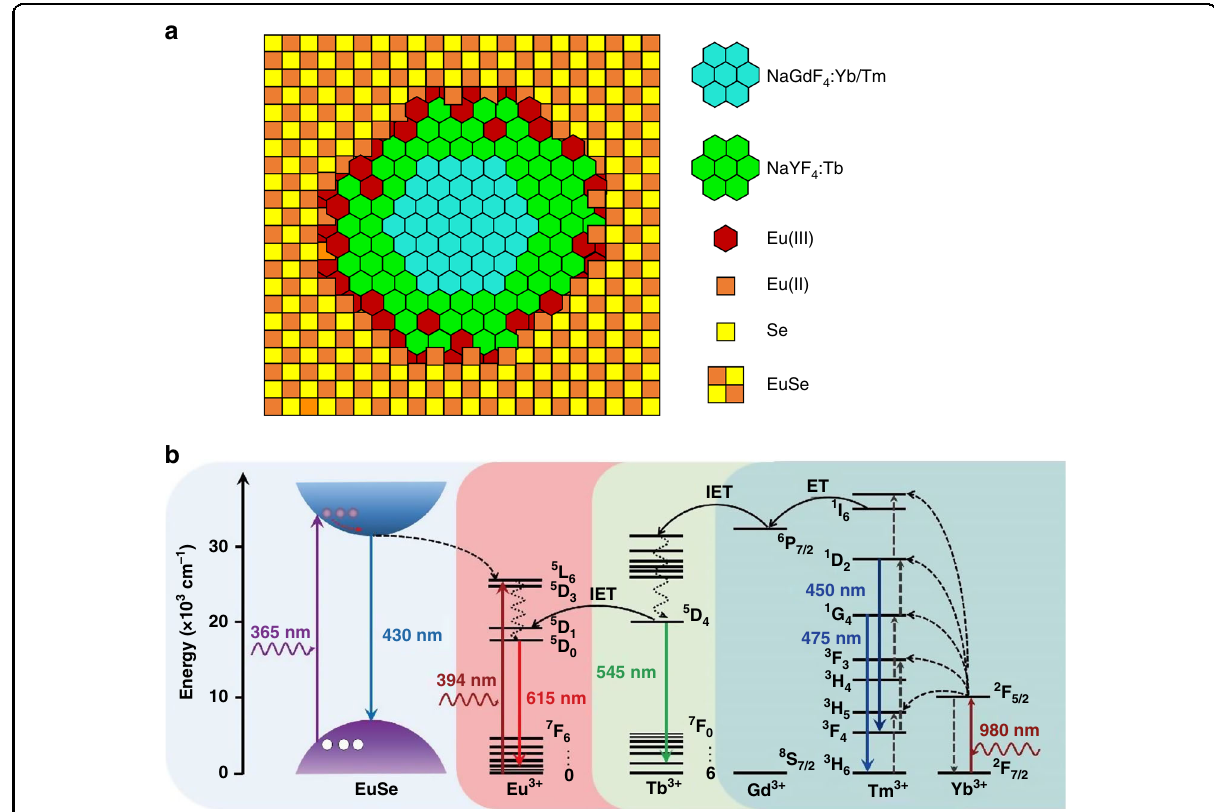
Fig. 1 Upconversion nanocrystal and semiconductor material fused into a single nanocomposite. a Epitaxial growth of the cubic semiconductor EuSe on hexagonal NaYF 4 is facilitated by replacing some surface lanthanide ions in the NaYF 4 host matrix by Eu 3 + , which is then reduced to Eu 2 + . b Energy transfer steps in the nanocomposite under UV (365 and 394 nm) excitation, which yields Stokes luminescence, and under NIR (980 nm) excitation, which yields anti-Stokes